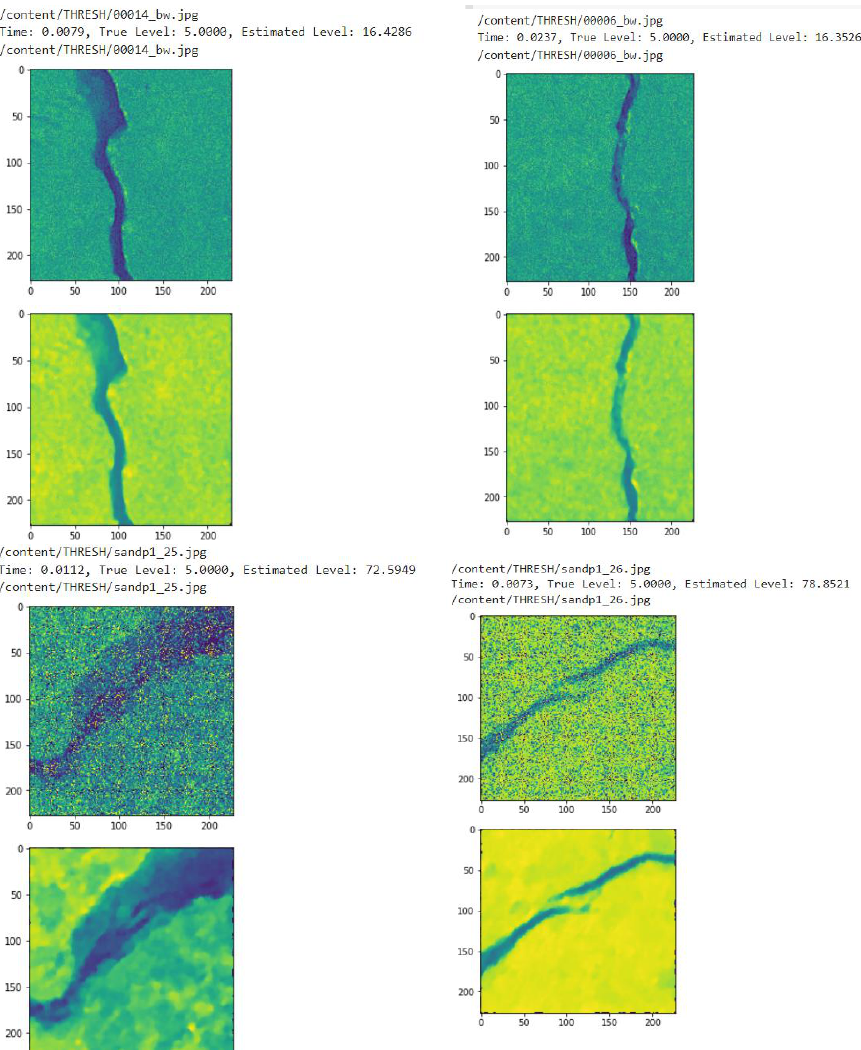
Figure 4. Noise estimation.